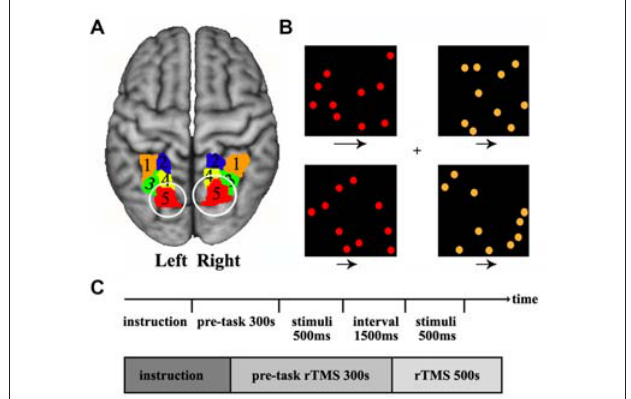
FIGURE 1 | Definition of the posterior superior parietal lobule (SPL) and the visual search task. (A) The posterior SPL was defined using a connectivity-based parcellation approach. The maximum probability map for the SPL subregions was created and the most posterior subregions (red, label 5) in left and right SPL were selected as the target brain sites of transcranial magnetic stimulation (TMS). The labels 1–5 is the five subregions in left and right SPL. (B) The stimulus displayed during a target-present color task trial. The subjects searched the visual display for targets defined by a conjunction of color and motion. Four square windows were used in the experiment. Each window contained 10 dots (orange or red) that moved at two speeds (fast or slow) during the experiment, and the arrows under each window specify the two speeds at which the dots could move. (C) The time courses of the visual stimuli and repetitive transcranial magnetic stimulation (rTMS) stimuli. The rTMS stimuli were applied for 300 s before behavioral task start and continued until the task finished.